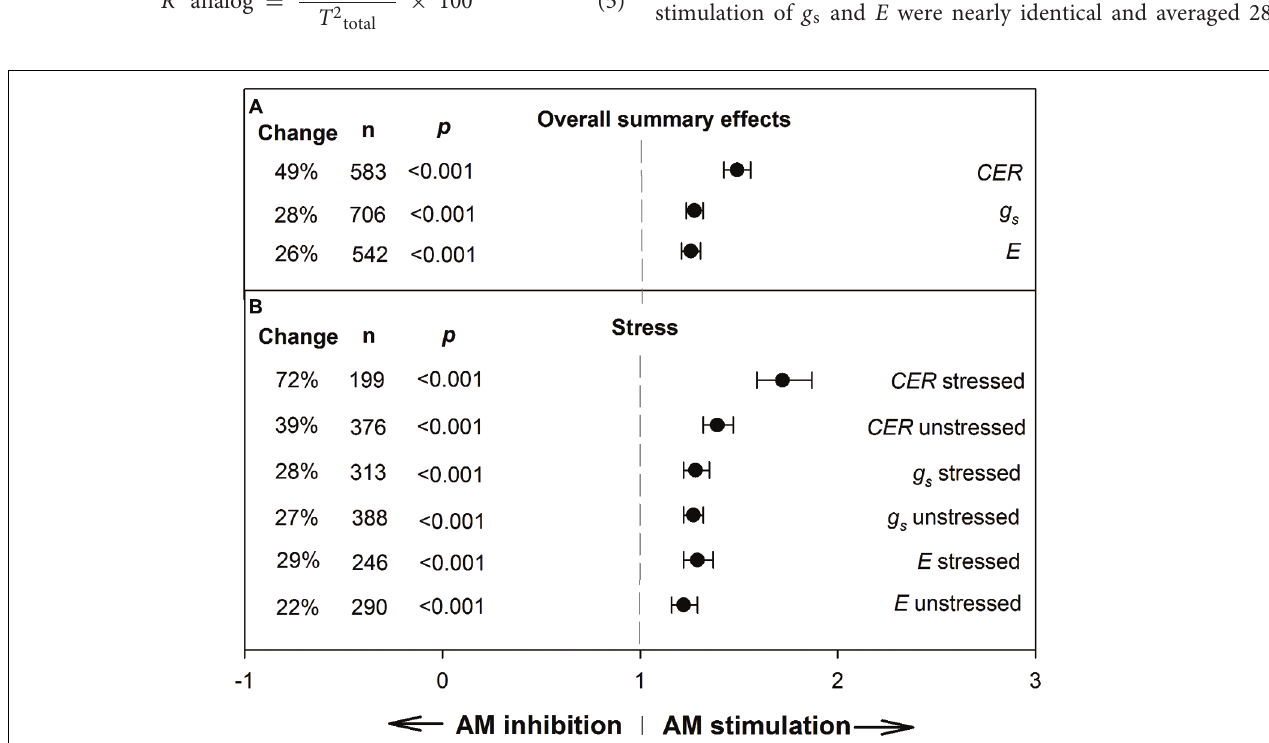
FIGURE 1 | Weighted summary effect sizes (response ratios) and 95% confidence intervals for AM influence on foliar carbon exchange rate (CER), stomatal conductance ( g s ), and transpiration rate ( E ). (A) Overall summary effects. (B) Summary effects for stress moderator. Change refers to raw percentage increase in the gas exchange parameter induced by AM symbiosis. n is number of studies contributing to the effect size. p ≤ 0.05 indicates that the moderator level was significantly different than 0.